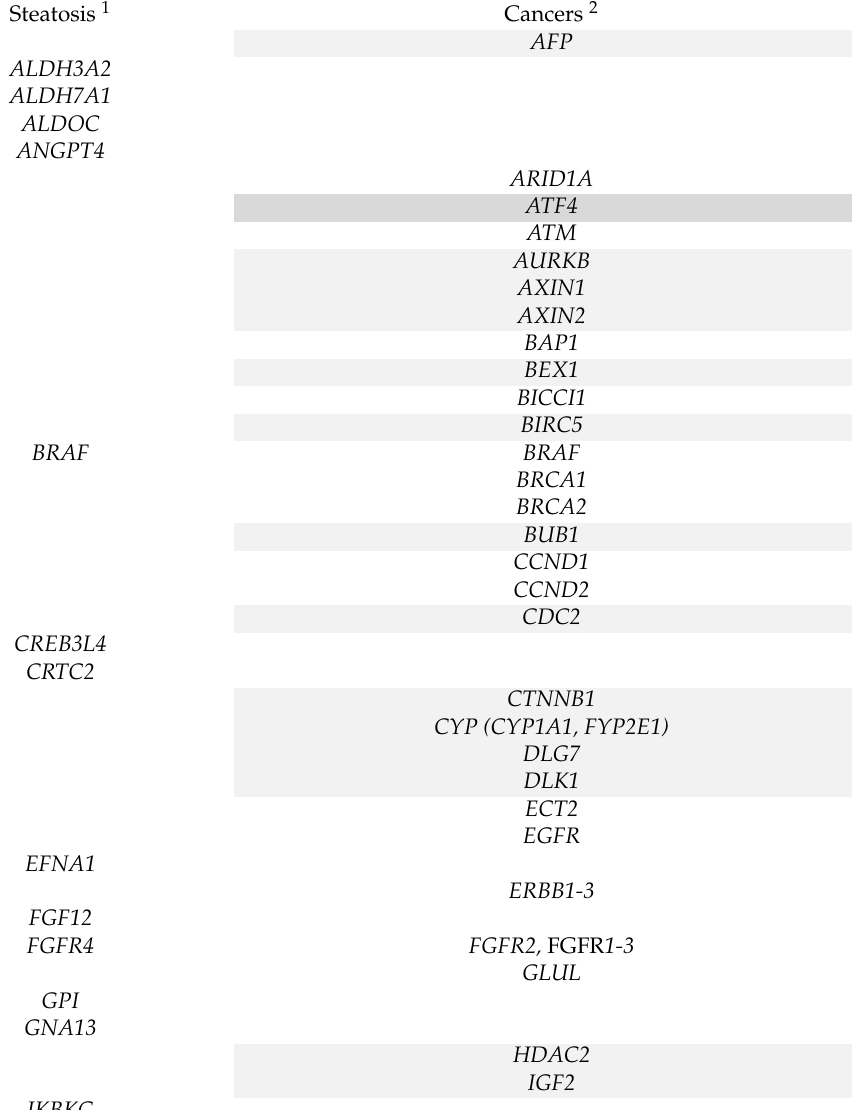
Table A1. Common genes reported in hepatic steatosis and hepatic